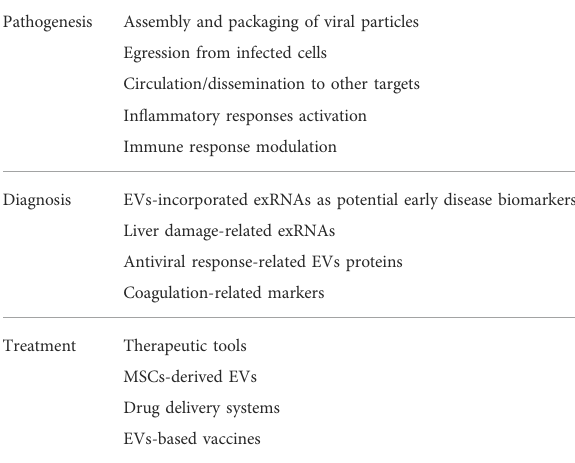
TABLE 1 Summary of the role of EVs in SARS-CoV-2 pathogenesis, diagnosis and treatment. Pathogenesis Assembly and packaging of viral